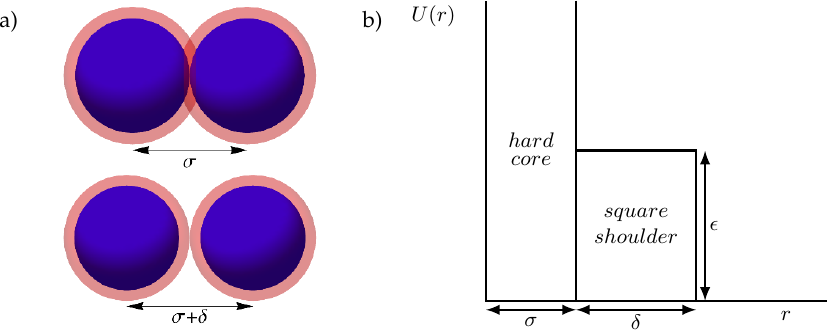
Figure 1. Schematic representation of the hard core square shoulder (HCSS) model. ( a ) Illustration of two pairs of particles (blue) with their interaction ranges (pink), at distance σ (top, energy U = (cid:101) ), and at distance σ + δ (bottom, energy U = 0); ( b ) Plot of the interaction